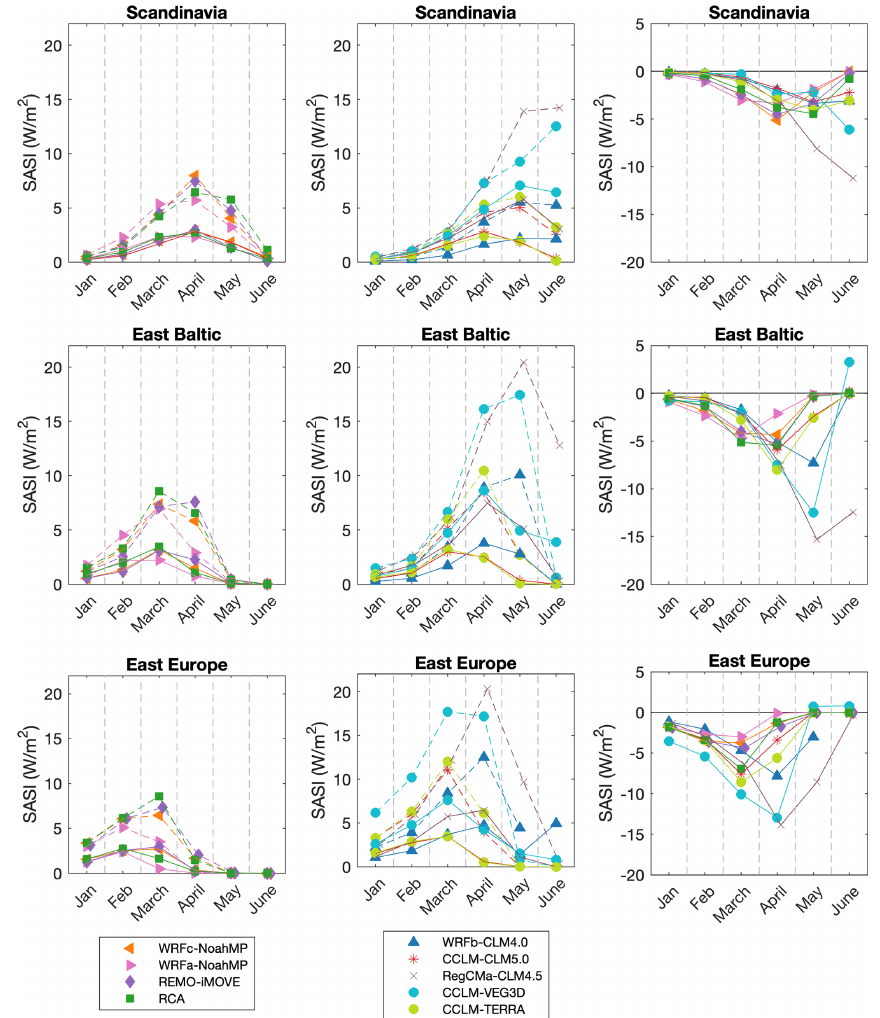
Figure 2. The first and second columns show the SASI values for the GRASS (dashed lines) and FOREST (solid lines) experiments averaged over the three different regions shown in Fig. 1. The nine simulations are divided into two different columns based on their values (high vs. low); the purpose of this separation is to ease interpretation of the results. The third column shows the impact of afforestation on SASI (FOREST −